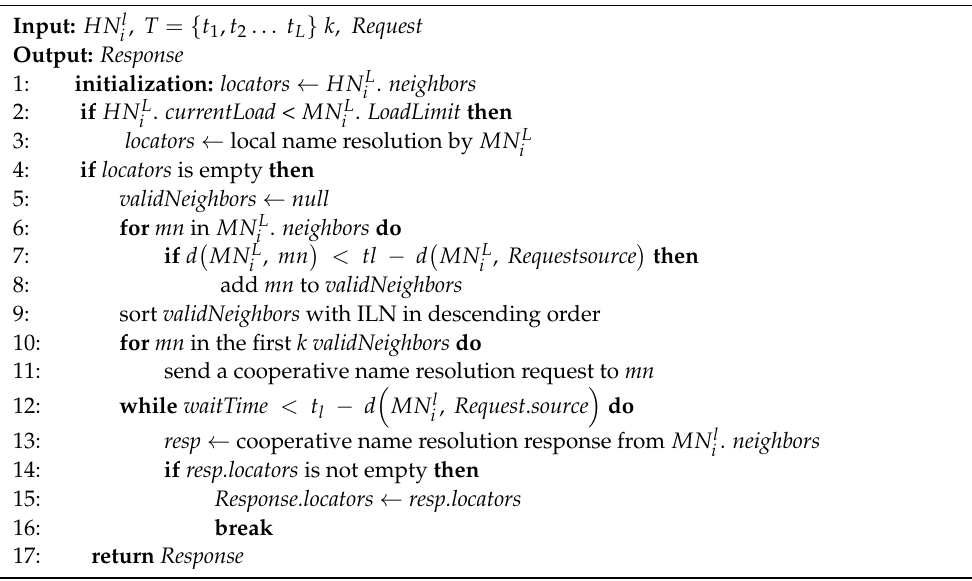
Algorithm 3: Cooperative